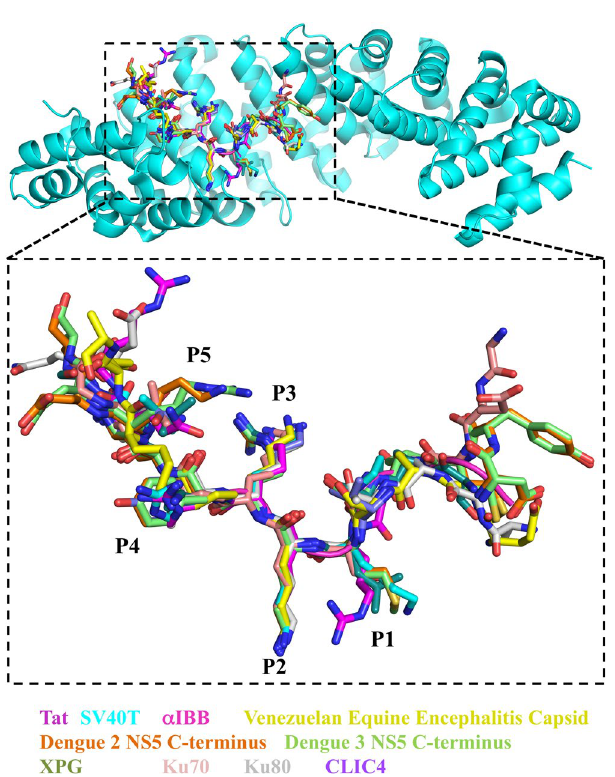
Figure 7. Overlay of cNLSs bound at the major site of importin- α . Conservation of NLS structures are coloured accordingly: Tat (magenta), SV40T (cyan), α IBB (pink), Venezeualan equine encephalitis virus (gold), Dengue 2 NS5 C-terminus (orange), Dengue 3 NS5 C-terminus (green), XPG (dark green), Ku70 (nude), Ku80 (grey), CLIC4 (purple), all overlaid onto Tat:NLS/CPP bound importin- α (cyan). Overlay of NLSs are enlarged within the P1-P5